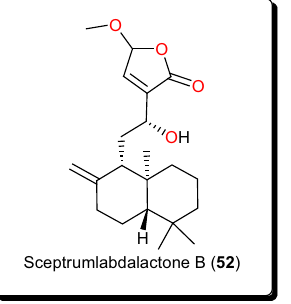
Fig. 9 Potent compound with selective activity for L. donovani , when compared with the activity against T. b. brucei